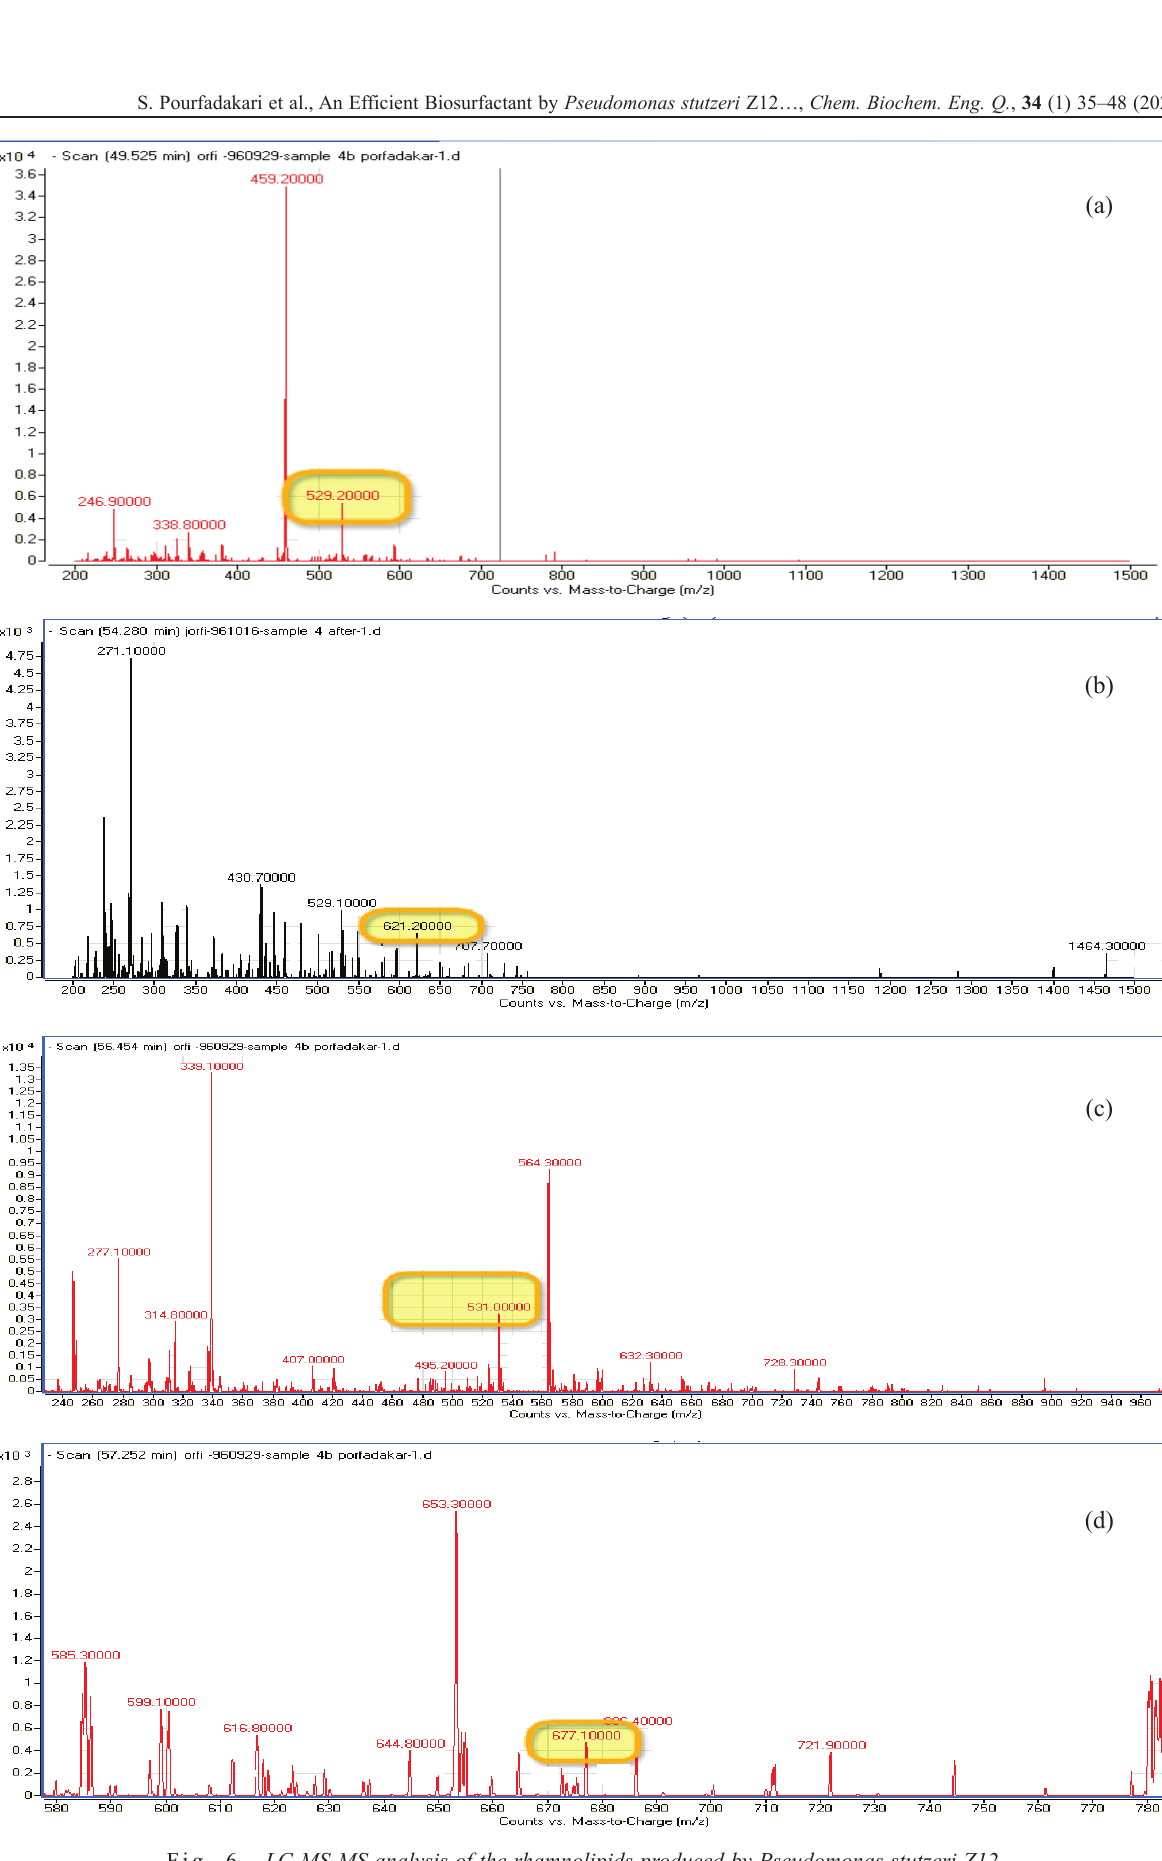
Fig. 6 – LC­MS­MS analysis of the rhamnolipids produced by Pseudomonas stutzeri